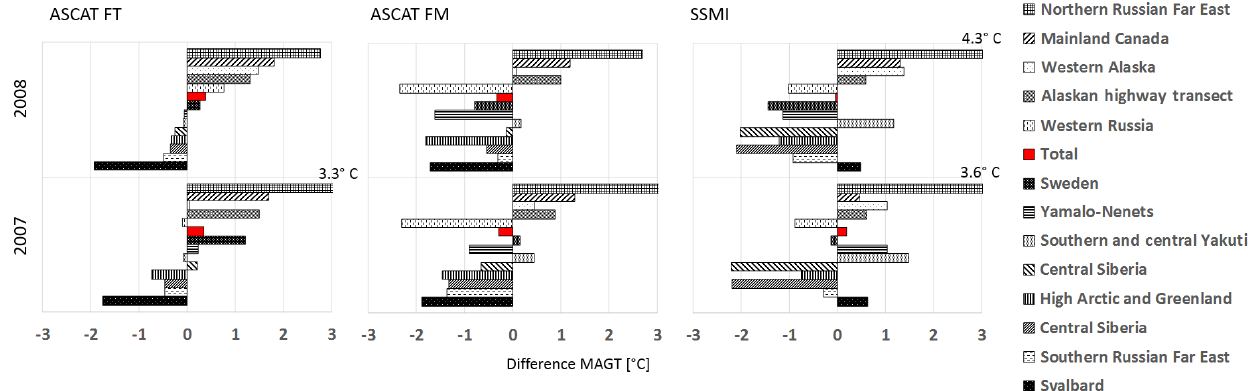
Figure 5. Difference between modelled MAGT c and in situ MAGT c (coldest sensor) by region (see Fig. 1) in 2007/2008 and 2008/2009. FT – days identified as frozen without melting snow are used; FM – days with melting snow are considered to be frozen ground in